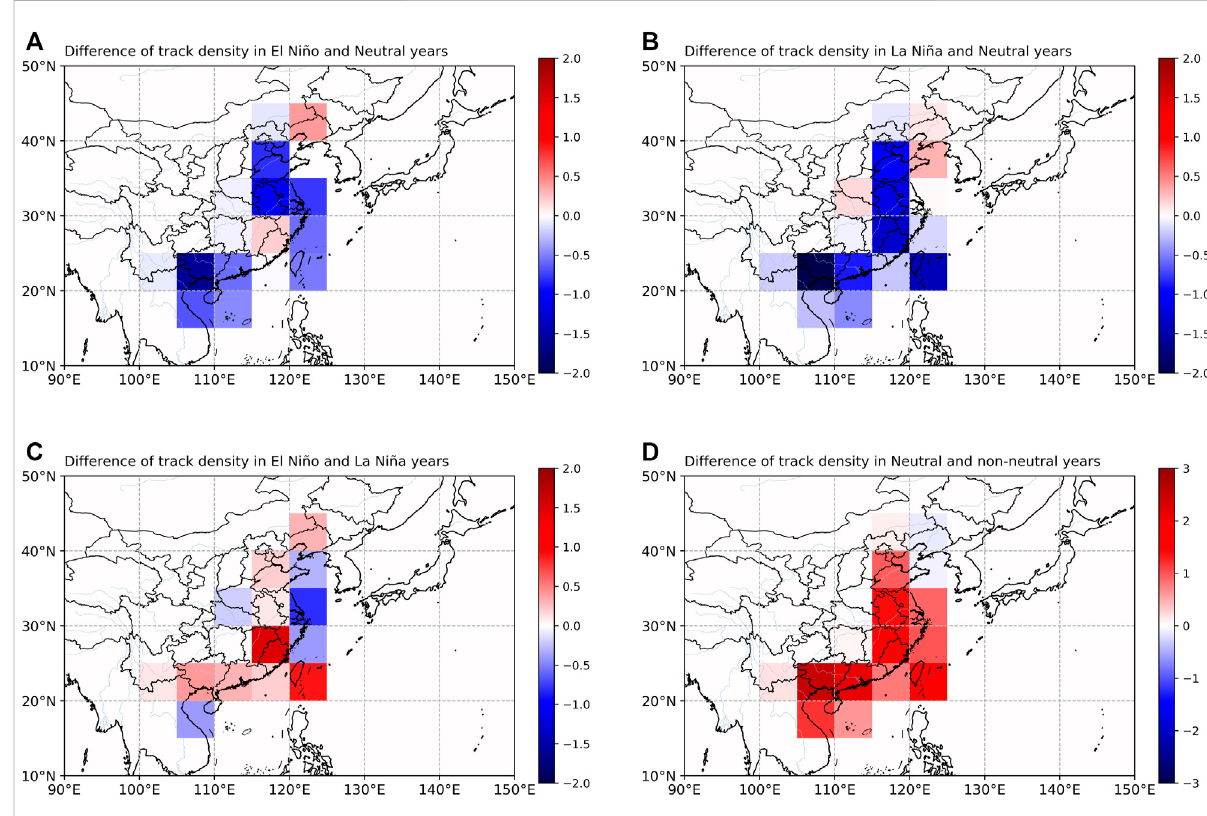
FIGURE 6 Spatial differences in overland track density for (A) El Niño years versus neutral years, (B) La Niña years versus neutral years, (C) El Niño years versus La Niña years and (D) Neutral years versus non-neutral